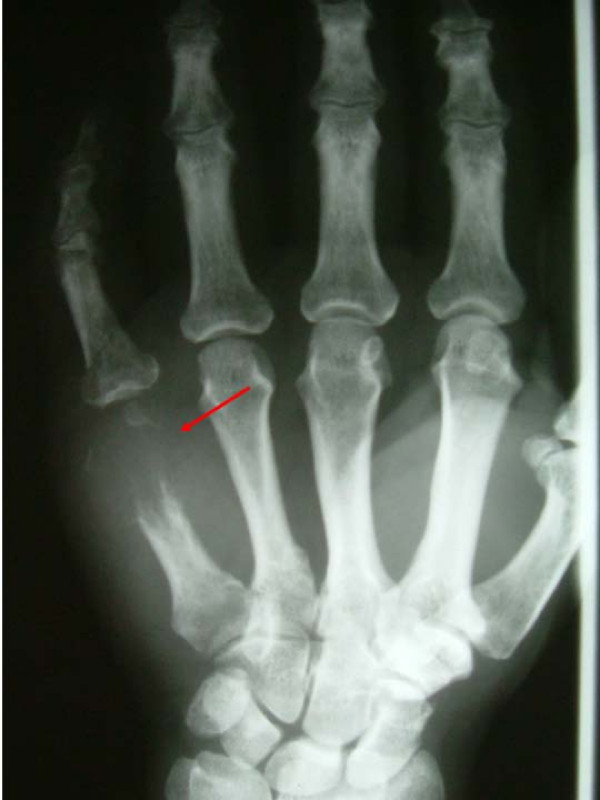
Destruction of the distal part of the 5th metacarpal.